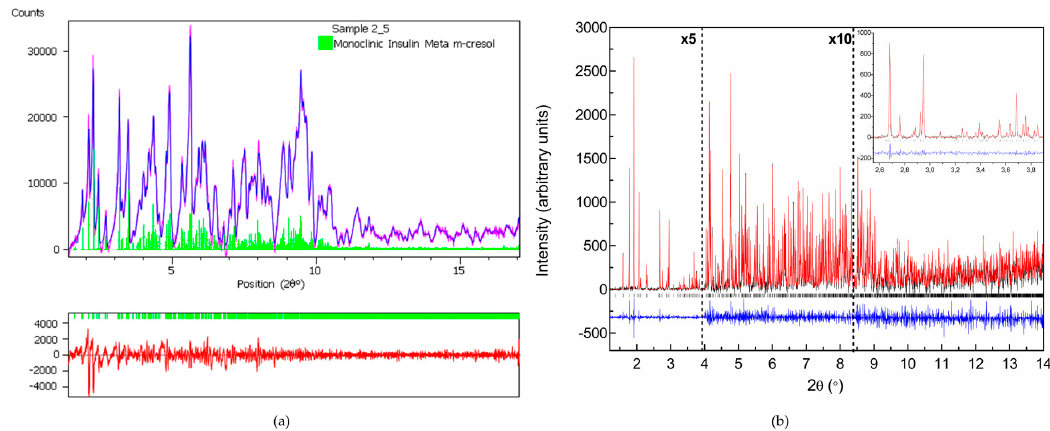
Figure 7. Pawley fit of ( a ) laboratory ( λ = 1.541874 Å, RT) and ( b ) synchrotron (ESRF, λ = 1.29994 (1) Å, RT) data of HI crystallized in the presence of m ‐ cresol resulting in monoclinic phase P 2 1( γ ) : ( a ) The pink, blue and lower red lines, represent the experimental data, the calculated pattern and the difference between them, respectively. The green bars (lower panel) correspond to Bragg reflections compatible with this monoclinic phase. ( b ) The black, red and lower blue lines represent the experimental data, the calculated pattern and the difference between them, respectively. The vertical black bars correspond to Bragg reflections compatible with this monoclinic form. The profiles have been expanded by a factor of five at Bragg angles larger than 4° and by a factor of ten at angles larger than 8.5° (Reproduction of Figures 5 and 6 from reference [56]. Reproduced with permission of the International Union of Crystallography).